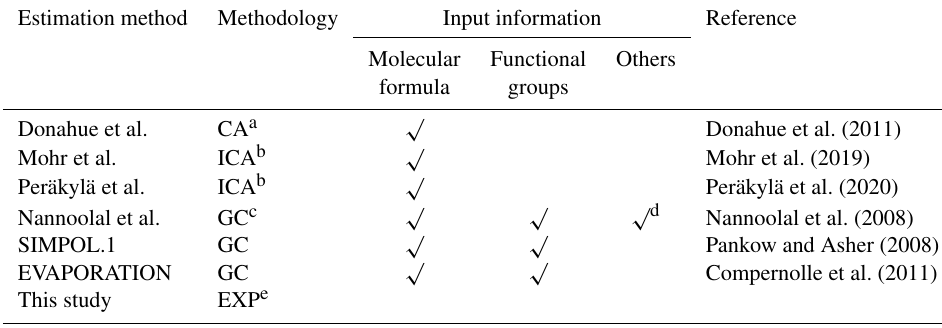
Table 1. Summary of estimation methods of saturation vapor pressure used in this study. Estimation method